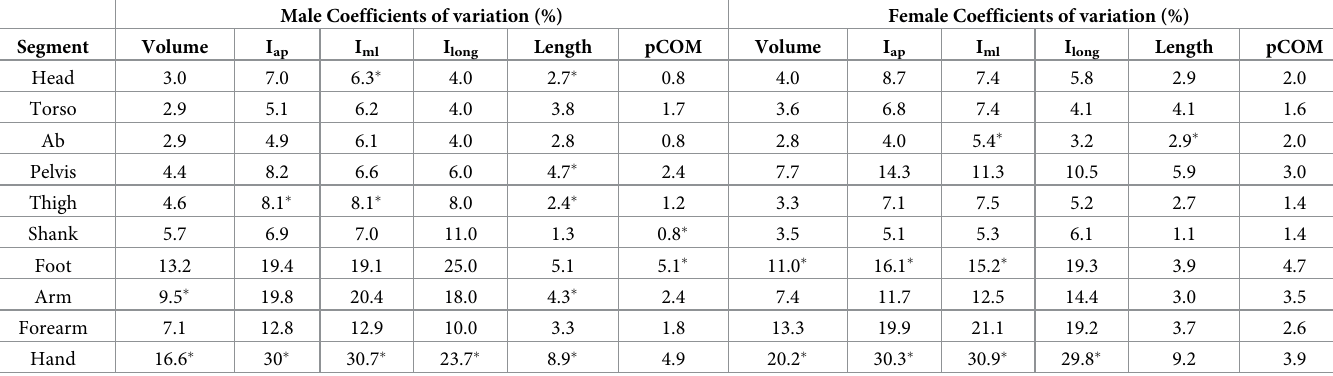
BSPs were evaluated for each segmentation for both male and female participants. Here an asterisk ( � ) indicates a p < 0.05 for the repeated-measures